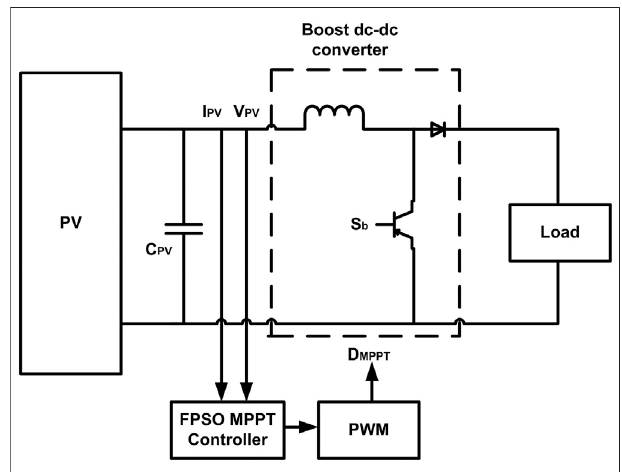
FIGURE 5 | System Con fi guration.